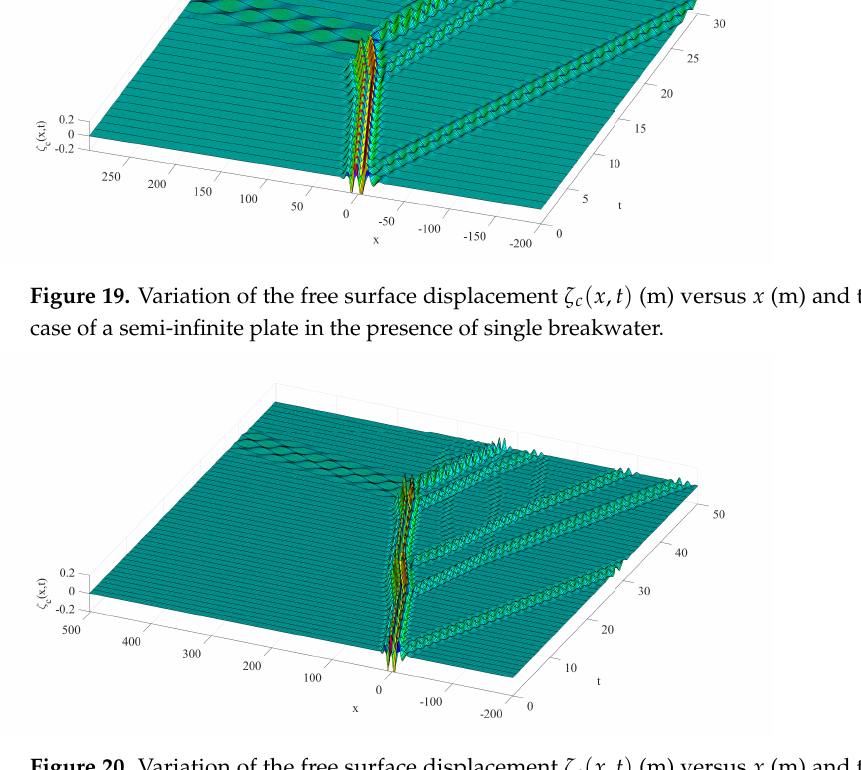
Figure 20. Variation of the free surface displacement ζ c ( x , t ) (m) versus x (m) and time t (s) in the case of a semi-infinite plate in the presence of double